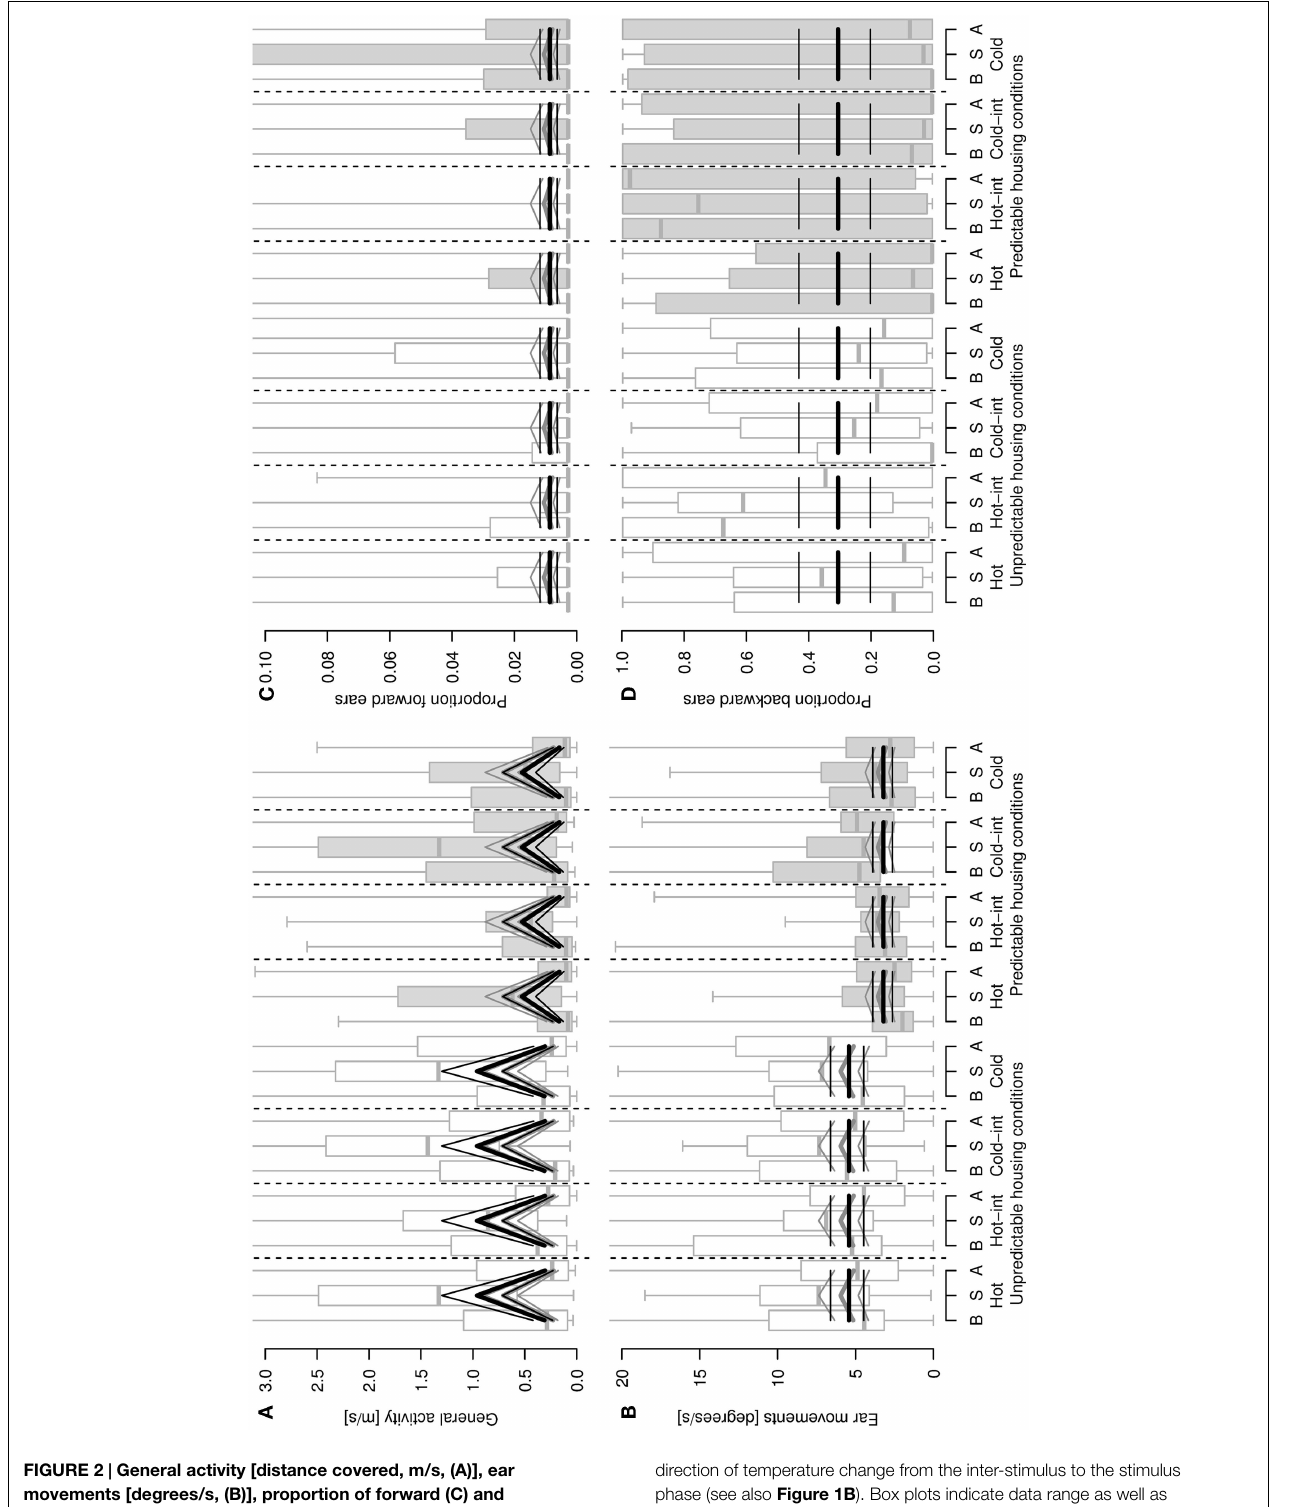
FIGURE 2 | General activity [distance covered, m/s, (A)], ear movements [degrees/s, (B)], proportion of forward (C) and backward (D) ear postures as a function of sheep’s housing condition (unpredictable, stimulus-poor and predictable, stimulus-rich), stimulus type and phase of the stimulus (B = before/pre-stimulus, S = stimulus, A = after/post-stimulus) . Hot-int (hot-intermediate) and cold-int (cold-intermediate) describe the